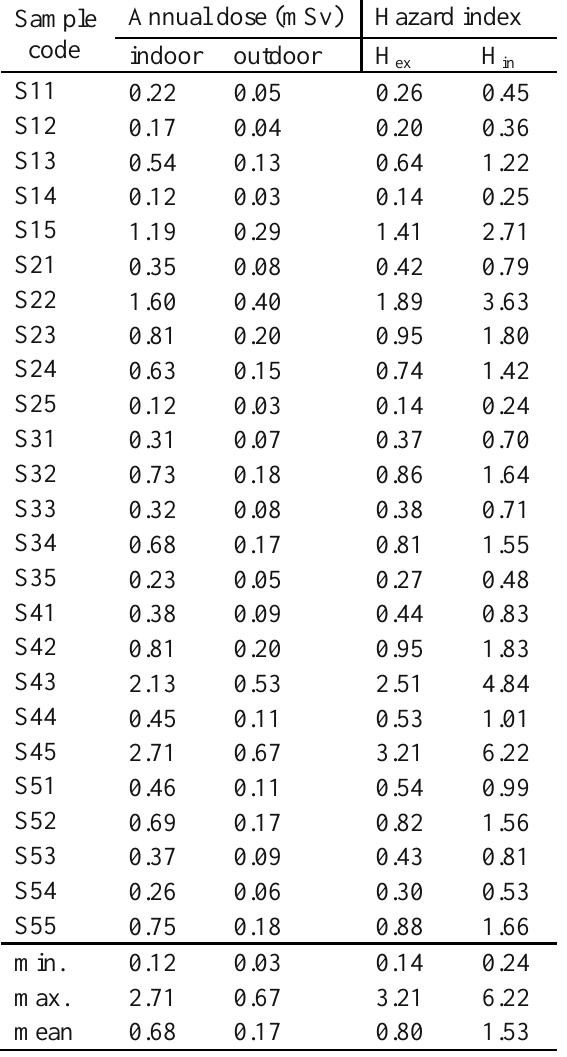
Table 2: Annual effective dose rate and hazard